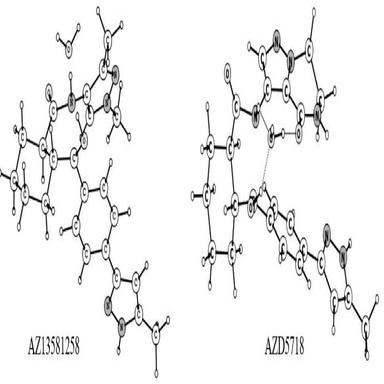
DFT optimized transition state structure for ring closure in AZ13581258 and AZD5718, respectively.